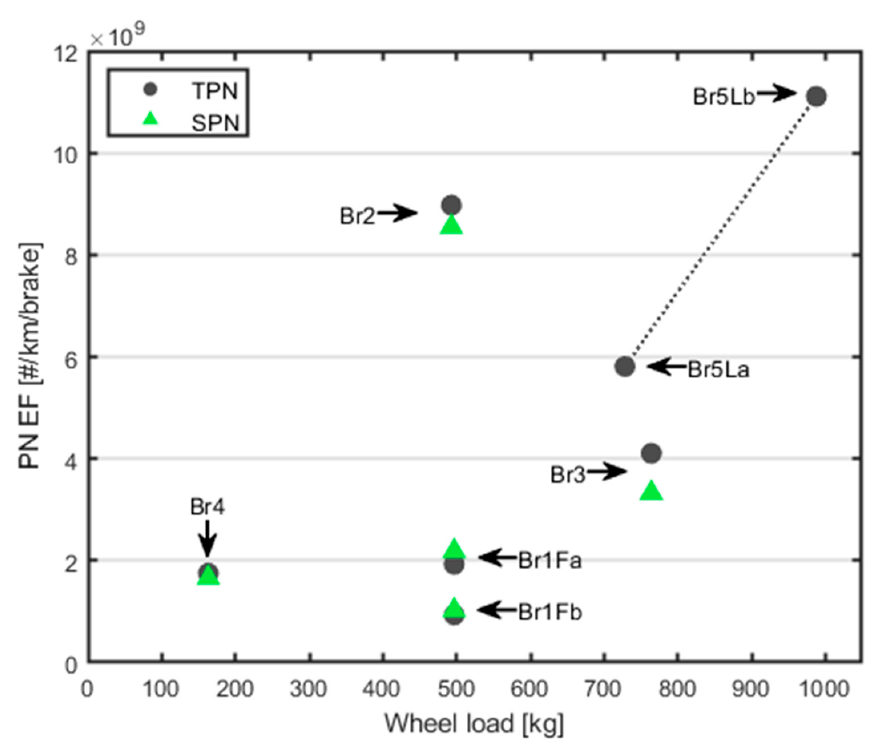
Figure 5. Overview of total and solid PN EF in dependence of the wheel load. The dashed line indicates the only repeated test with an identical brake system and variation in test mass.